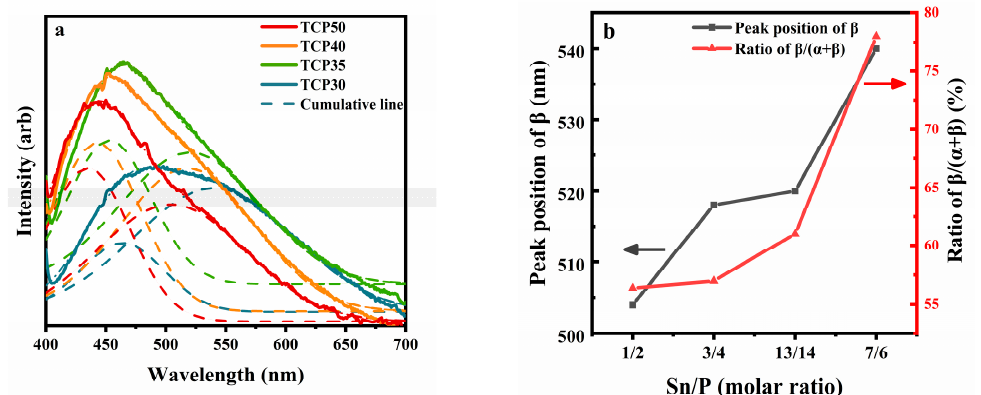
Figure 2. ( a ) PL spectra of TCP glasses. Two emission peaks obtained by Gaussian fitting are marked: ( b ) Peak area ratio β / ( α + β ) and peak position in the β -band as a function of the P/Sn ratio.